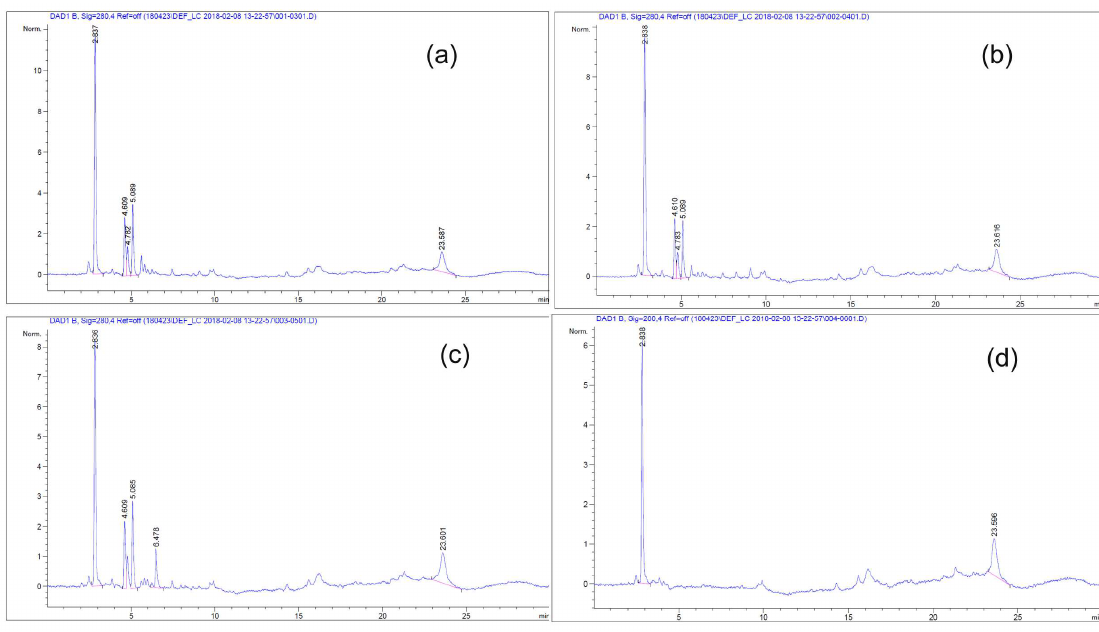
Figure 12. HPLC chromatogram of T65 embedded SBA-15 for sustainable control release test. ( a ) 0 day, ( b ) first day, ( c ) second day, and ( d ) third